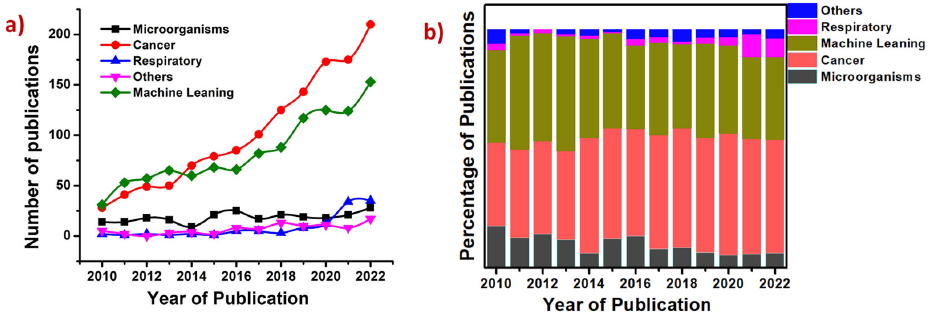
Figure 2. ( a ) Trends in research on SERS based plasmonic applications in the detection of microor- ganisms, cancers, respiratory diseases, other diseases such as heart ailments and diabetes and the use of different machine learning techniques for SERS based biosensing. ( b ) Bar chart with percentage contribution from each area shown on the label for the past 12 years. Source: Scopus search with the keywords mentioned in both the panels as on 5 January 2023.